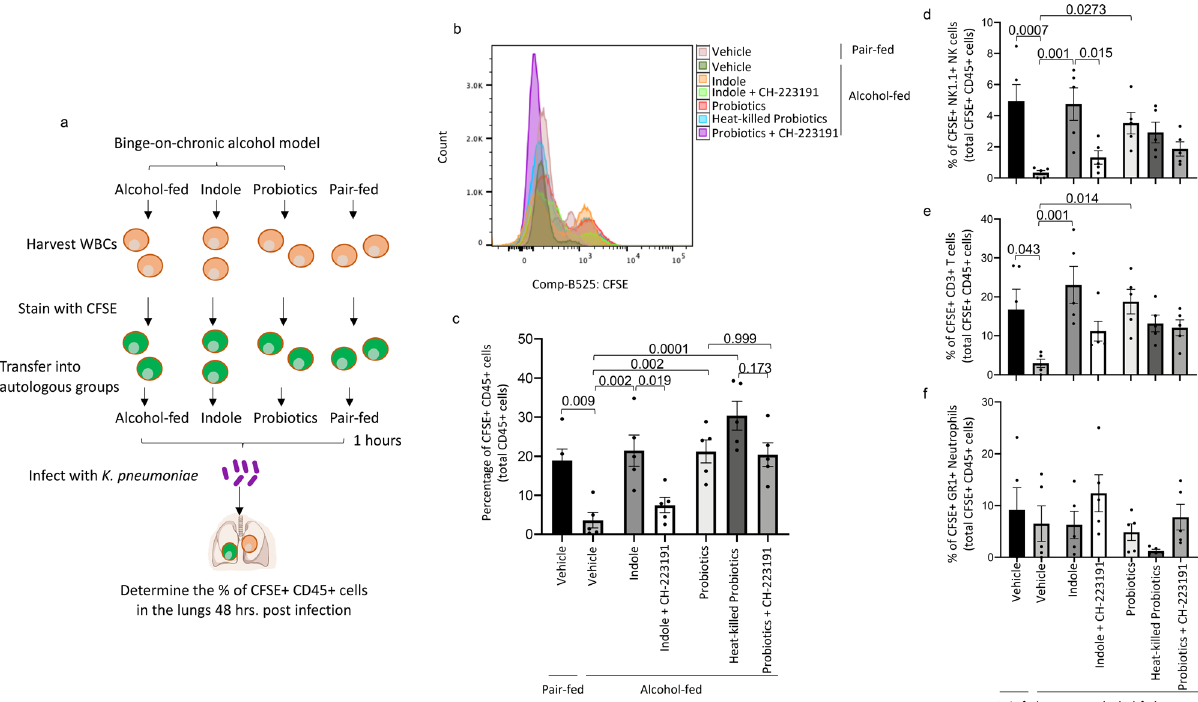
Fig. 10 Microbiota supplementation mitigates alcohol-associated impairment of immune cell traf fi cking. Binge-on-chronic alcohol-fed mice with and without treatment were given CFSE labeled CD45 + immune cells, from autologous treatment donors, 1 h prior to infected with Klebsiella and sacri fi ced 48h later. a Experimental schema. b Representative histograms of CFSE + CD45 + immune cells in the lungs of mice after 48h of post-infection, all treatments are overlaid. c The percentage of CFSE + CD45 + immune cells in the lungs after 48h of post-infection. The percentage of CFSE + CD45 + . d NK1.1 + natural killer cells. e CD3 + T-cells, and f GR1 + neutrophils in the lungs after 48h of post-infection. Bars represent the mean ±SEM and dots represent individual mice. P values are indicated in the fi gure and were determined by one ‐ way ANOVA with Sidak ’ s multiple comparison test. N =